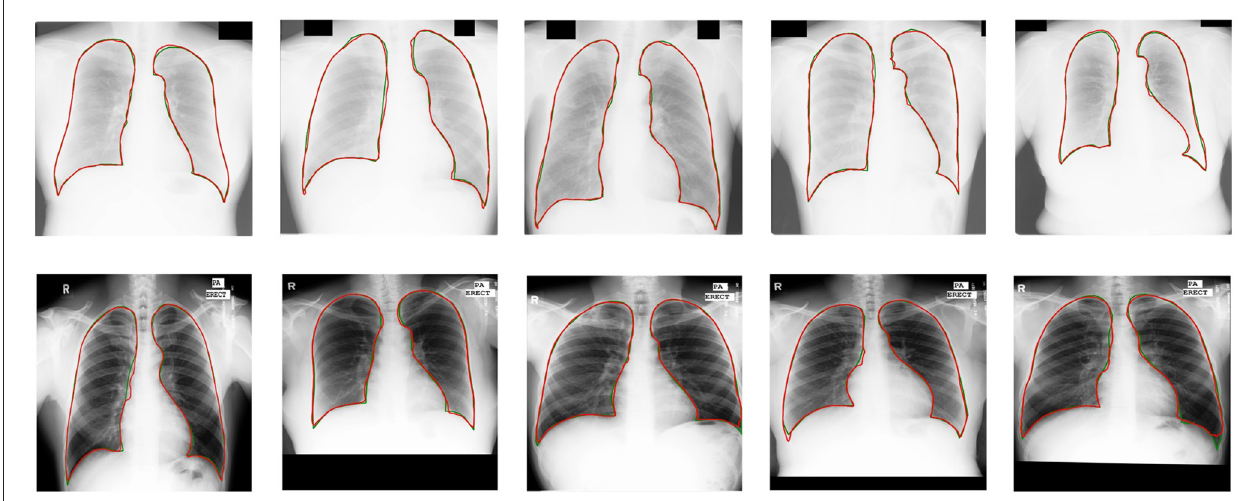
FIGURE 5 | Semi-supervised results (25% annotated data) with U-shaped GAN. The radiographs from the Japanese Society of Radiological Technology (JSRT) dataset and Montgomery County (MC) dataset appear at the top and bottom, respectively. Green and red contours indicate the true ground and automatic segmentation results, respectively.